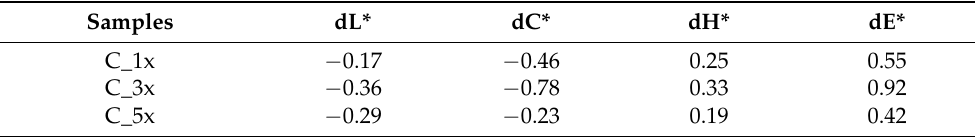
Table 5. Change in color coordinates of the cotton sample without mordants after 1st, 3rd and 5th washing cycle (compared with C_0x).